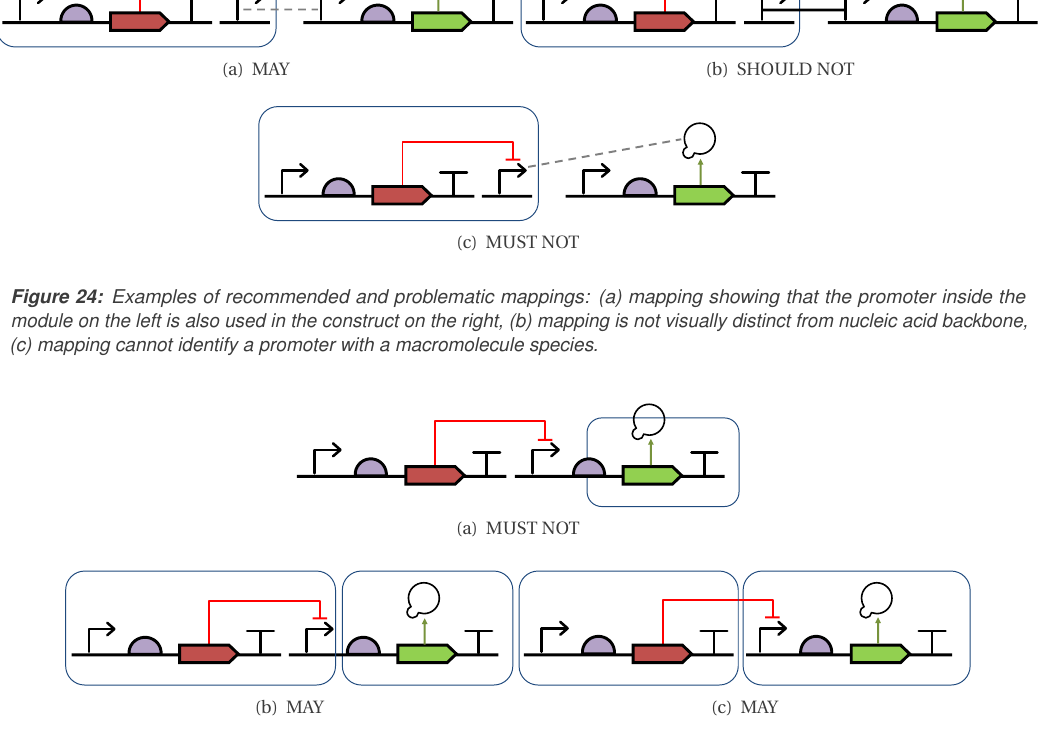
Figure 25: Examples of recommended and problematic boundary intersections: (a) sequence feature and molecular species glyphs MUST NOT intersect a module boundary, (b) implicit mapping from the promoter in the left module and the regulated elements in the right module to a nucleic acid construct ordering both into a complete functional unit, (c) implicit mapping from the CDS in the left module and the promoter in the right module to instances in the complete system in which the CDS inhibits the promoter (presumably by a repressor